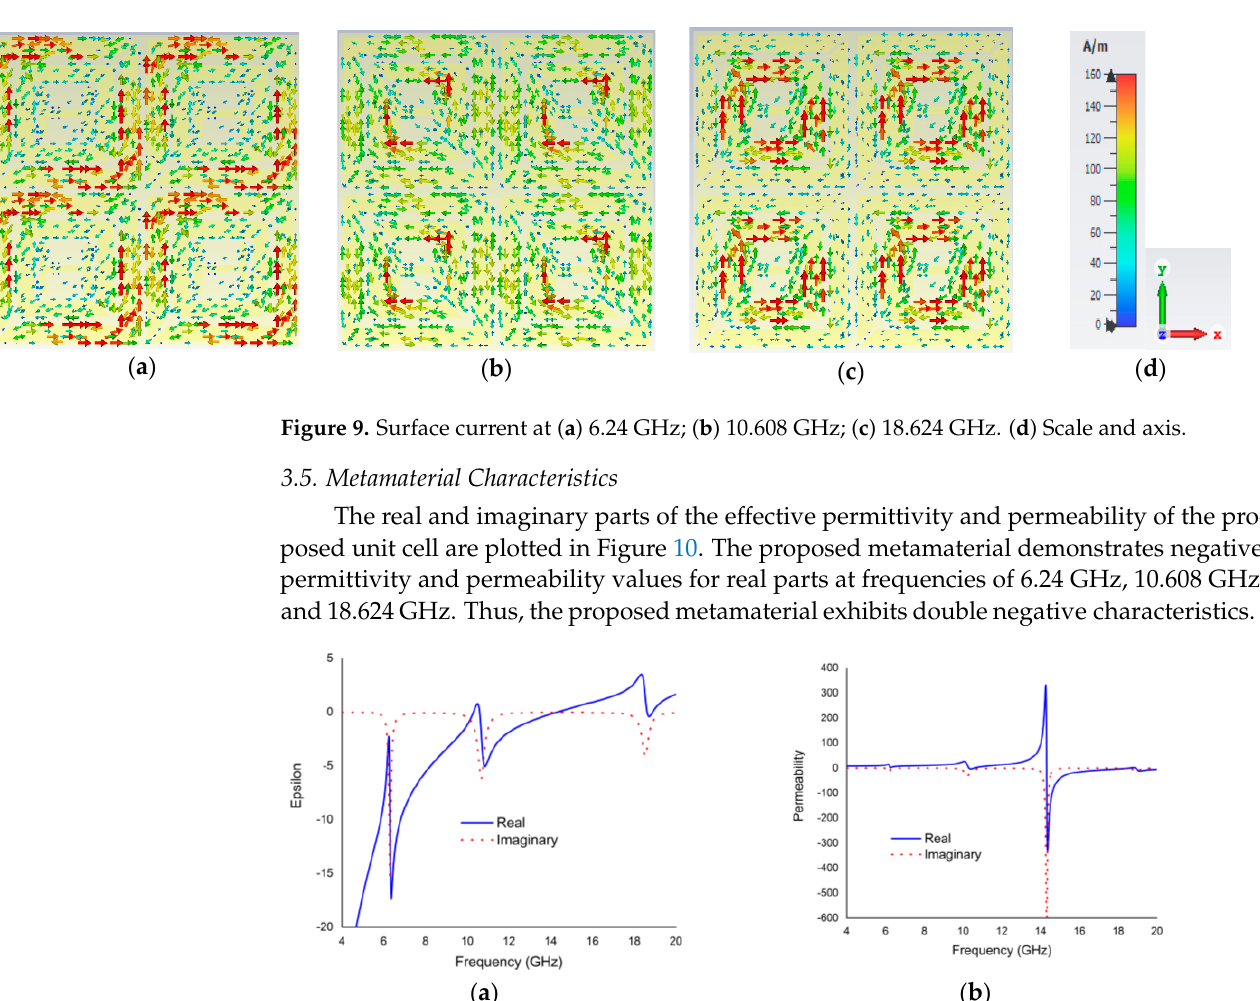
Figure 8. Magnetic field at ( a ) 6.24 GHz; ( b ) 10.608 GHz; ( c ) 18.624 GHz. ( d ) Scale and axis.